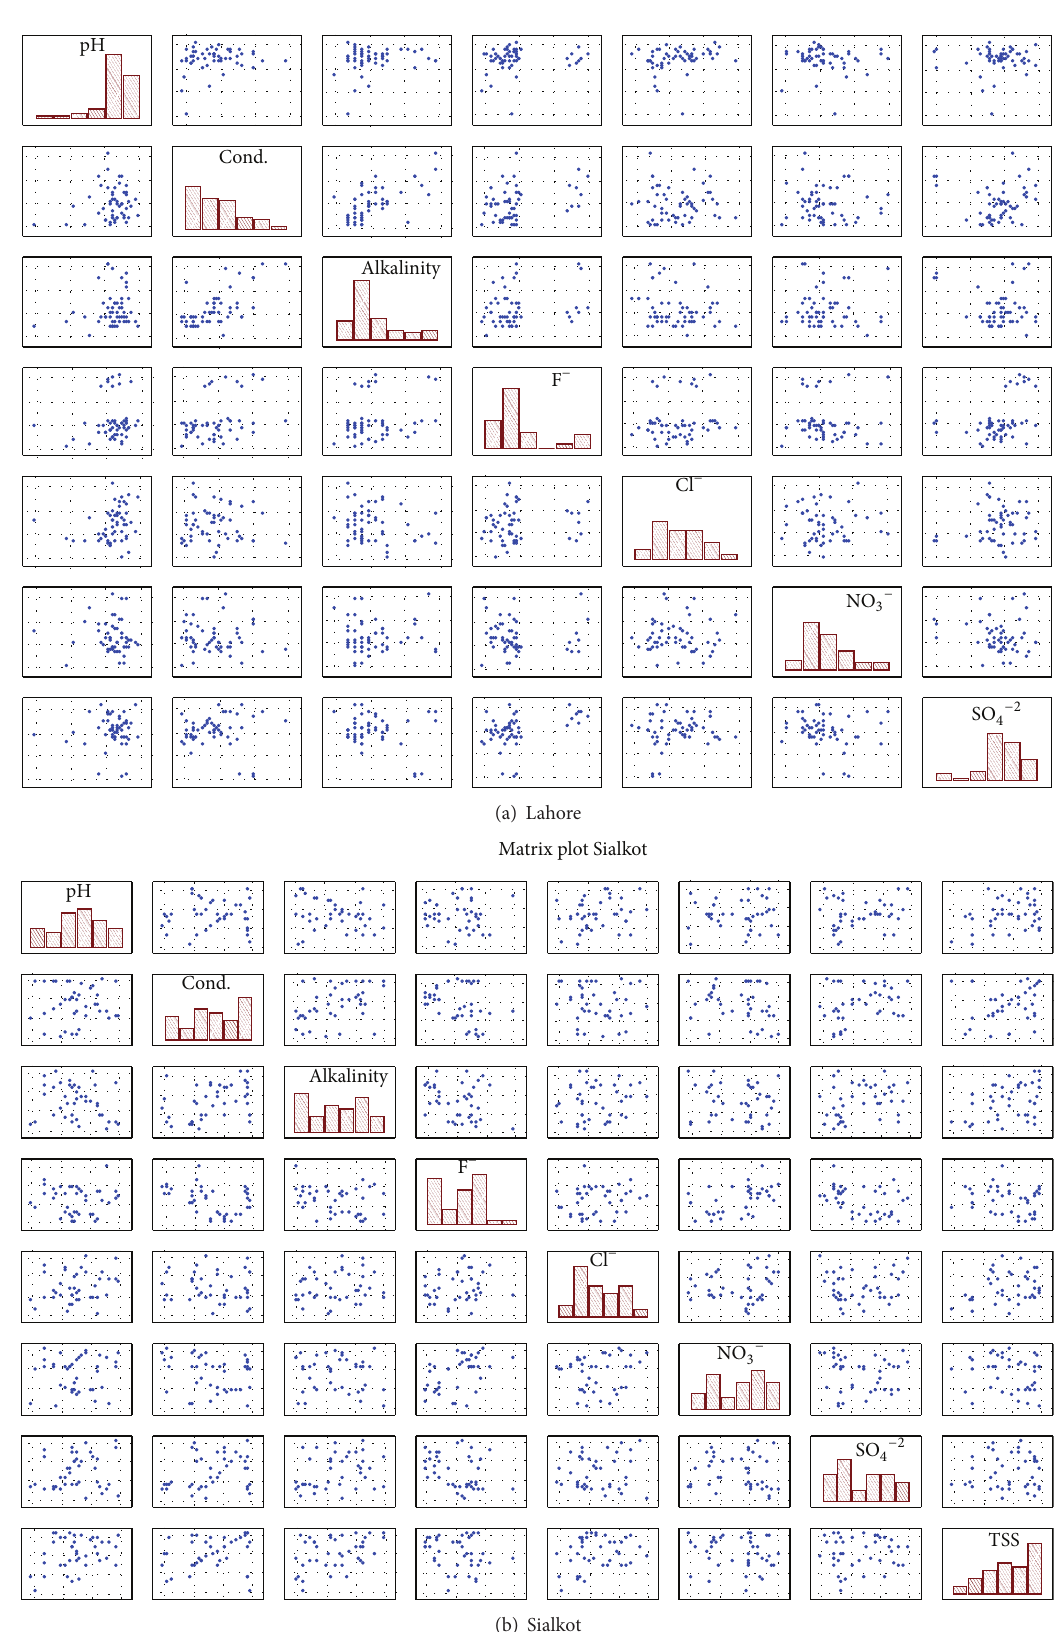
Figure 4: Matrix plot for drinking water samples from Lahore and